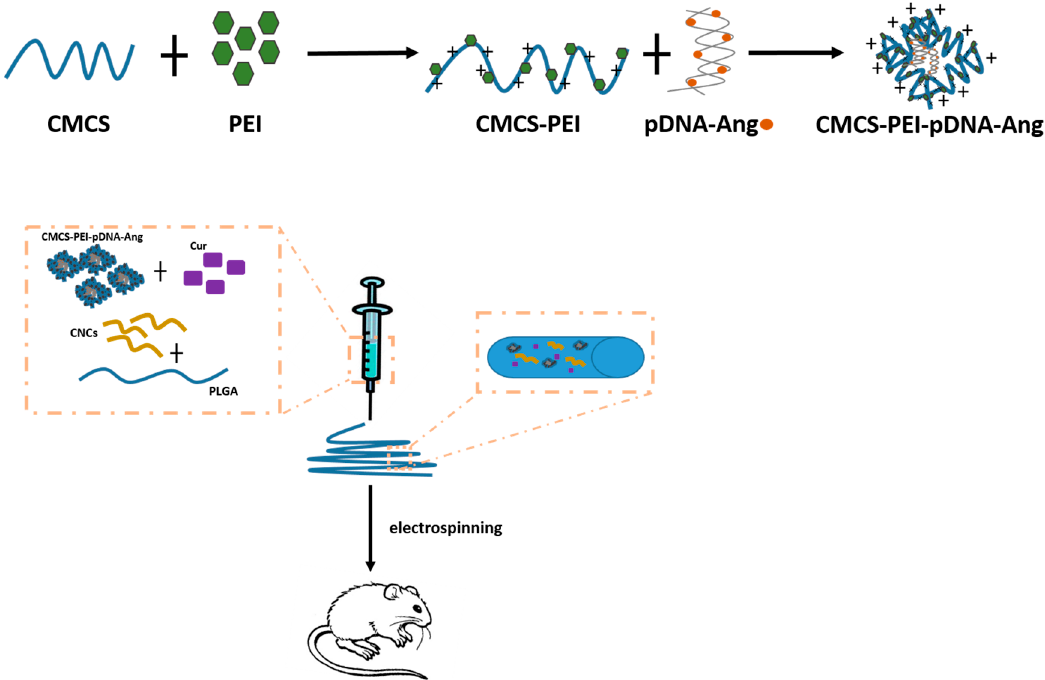
Figure 7. Schematic illustration of reparation of PEI-CMCS/pDNA complex nanoparticles, and assembly with Cur, CNC and PLGA; electrospinning was used to deliver the composite nanofibers to rat wounded skin. Redrawn for ref [70]. ANG = Angiogenin; CMCS = carboxymethyl chitosan; Cur = curcumin; pDNA = plasmid DNA; PEI = polyethyleneimine; PLGA = poly( D , L -lactic-co-glycolic acid).